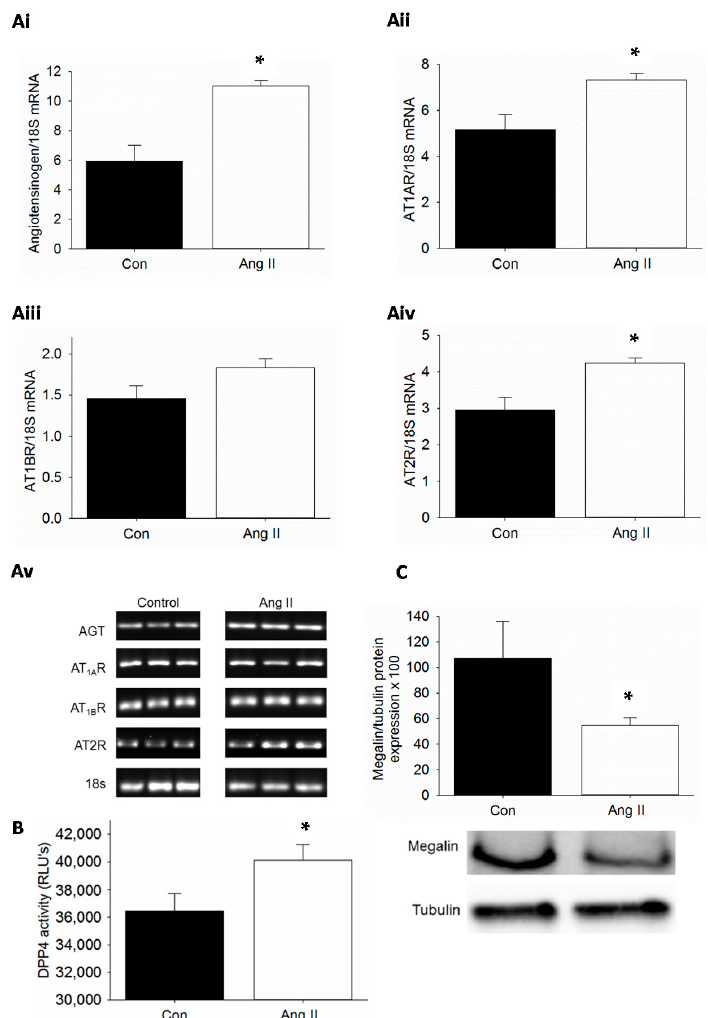
Figure 1. Ang II infusion activates the renin-angiotensin system (RAS) and dipeptidyl peptidase 4 (DPP4) and suppresses megalin protein levels in mice: ( A ) Quantification of differential mRNA expression of RAS in the kidney ( Ai – Aiv ) and depiction of actual bands that were used for quantification ( Av ); ( B ) DPP4 activity in the kidney expressed as relative light units (RLUs); and ( C ) megalin protein expression by immunoblot of kidney lysates. n = 3–4; * p < 0.05; AGT: Angiotensinogen; AT 1A R: Angiotensin type 1A receptor; AT 1B R: Angiotensin type 1B receptor; AT2R: Angiotensin type 2 receptor; 18s: 18s ribosomal RNA; Con: Saline-infused mice; Ang II: Ang II-infused mice (200 ng/kg/min).